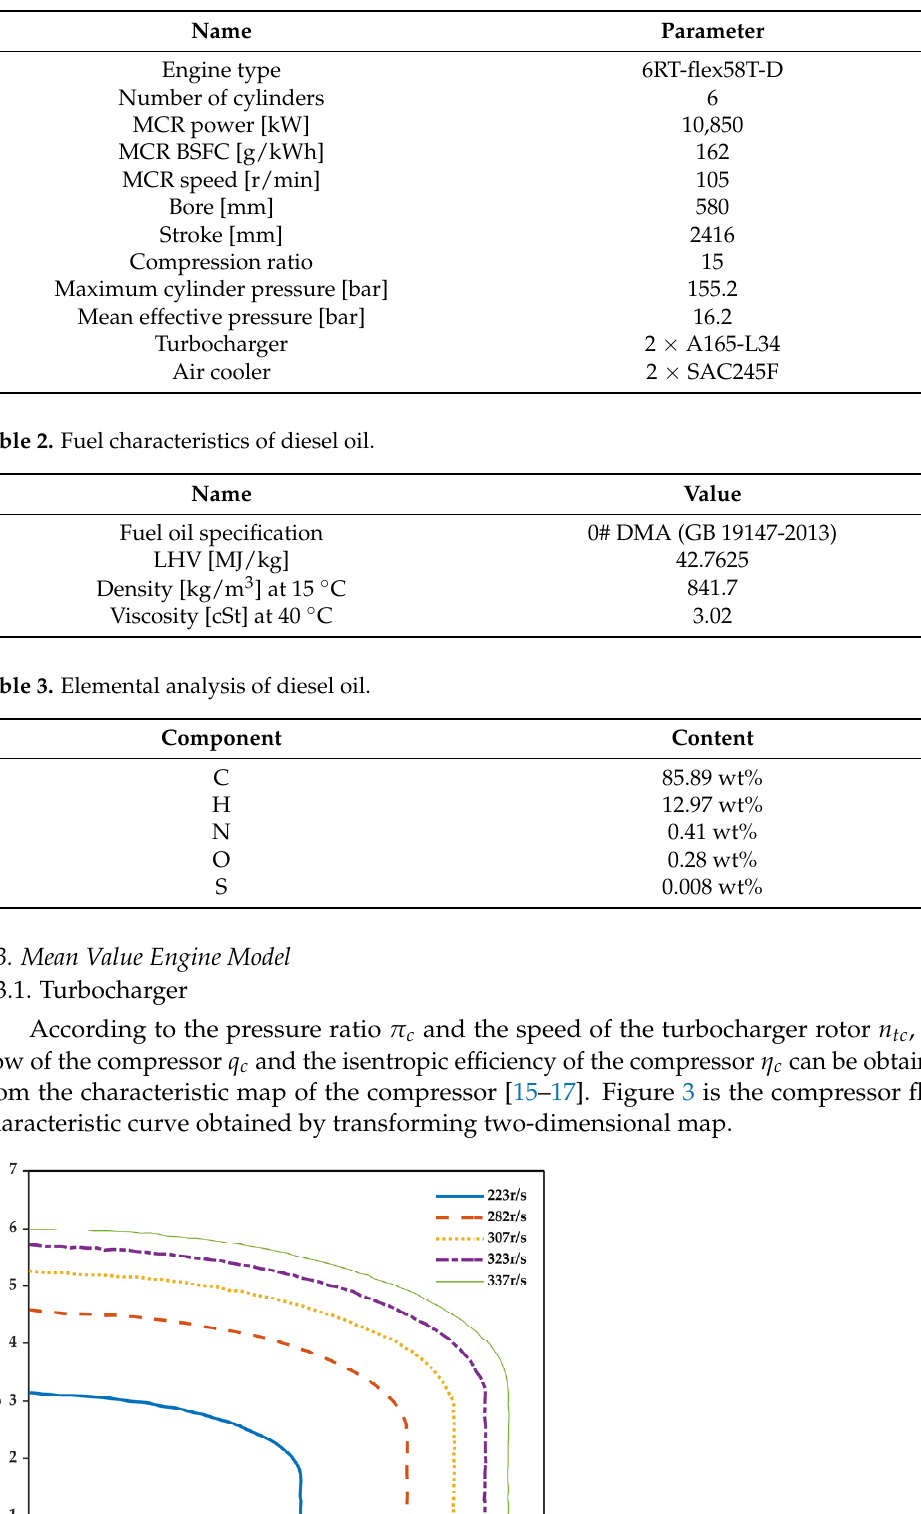
Table 1. Technical parameters of the parent engine.